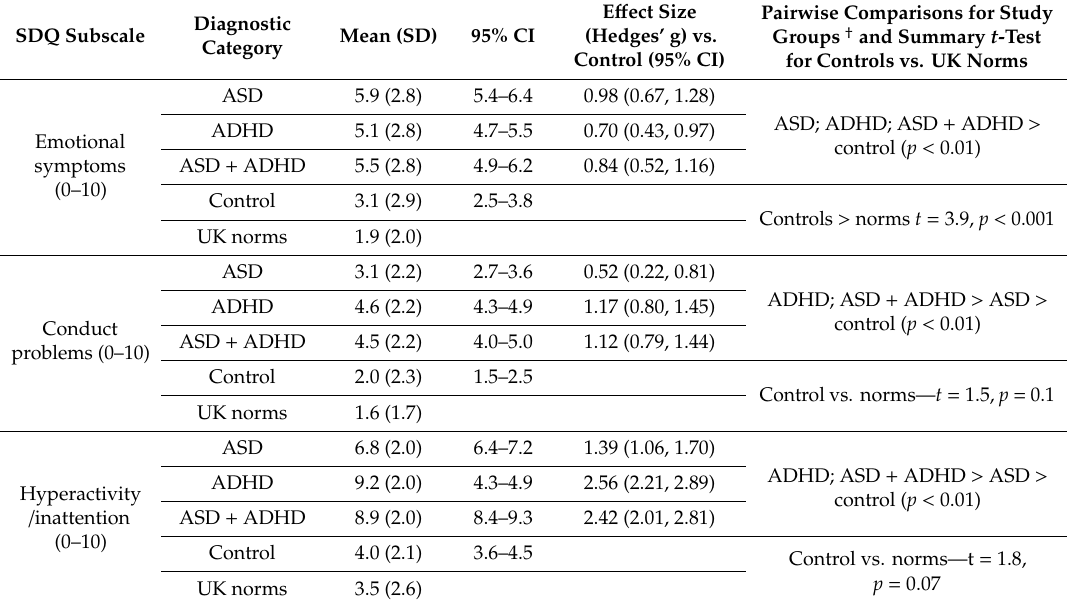
Table 1. Strengths and Di ffi culties Questionnaire data for neurodevelopmental disorders (NDD) clinical groups and controls during lockdown, and UK (pre-COVID-19) norms ( n = 10,298) [4]. E ff ect Size Pairwise Comparisons for Study Diagnostic SDQ Subscale Mean (SD) 95% CI (Hedges’ g) vs. Groups † and Summary t -Test Category Control (95% CI) for Controls vs. UK